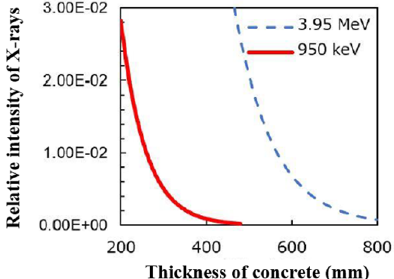
Figure 10. Calculated results of attenuation of the X-rays in concrete from the 950 keV/3.95 MeV X- ray sources. X-ray